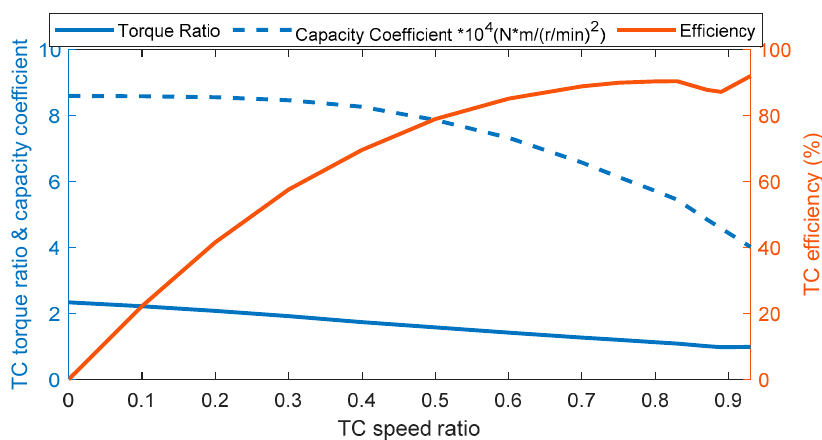
Figure 3. The original characteristics of the torque converter.